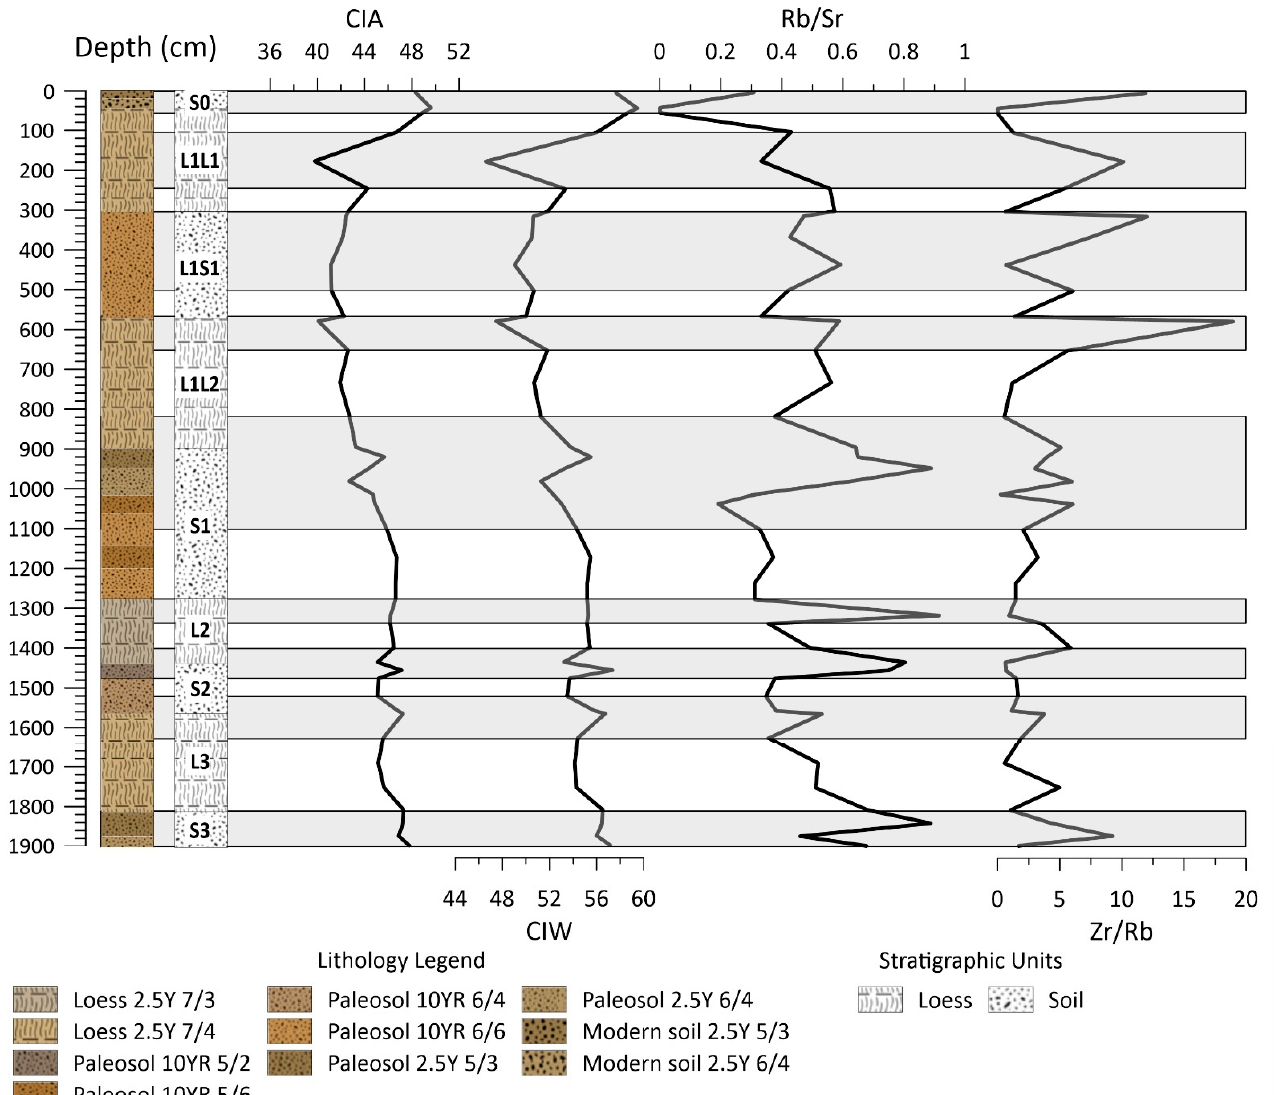
Figure 4. Geochemical indices used to explore weathering in the loess-paleosol sequence.